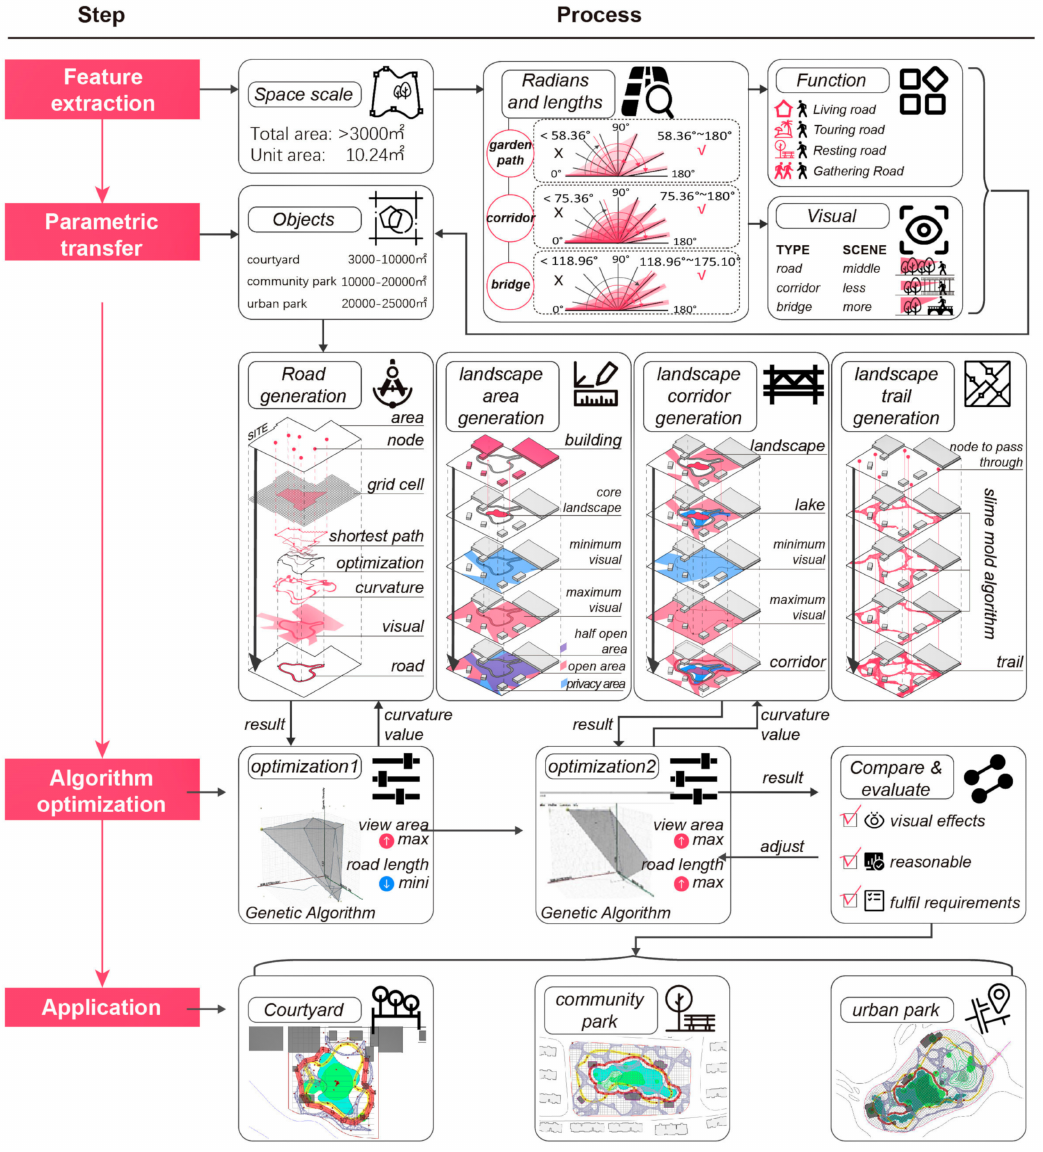
Figure 1. Method flow